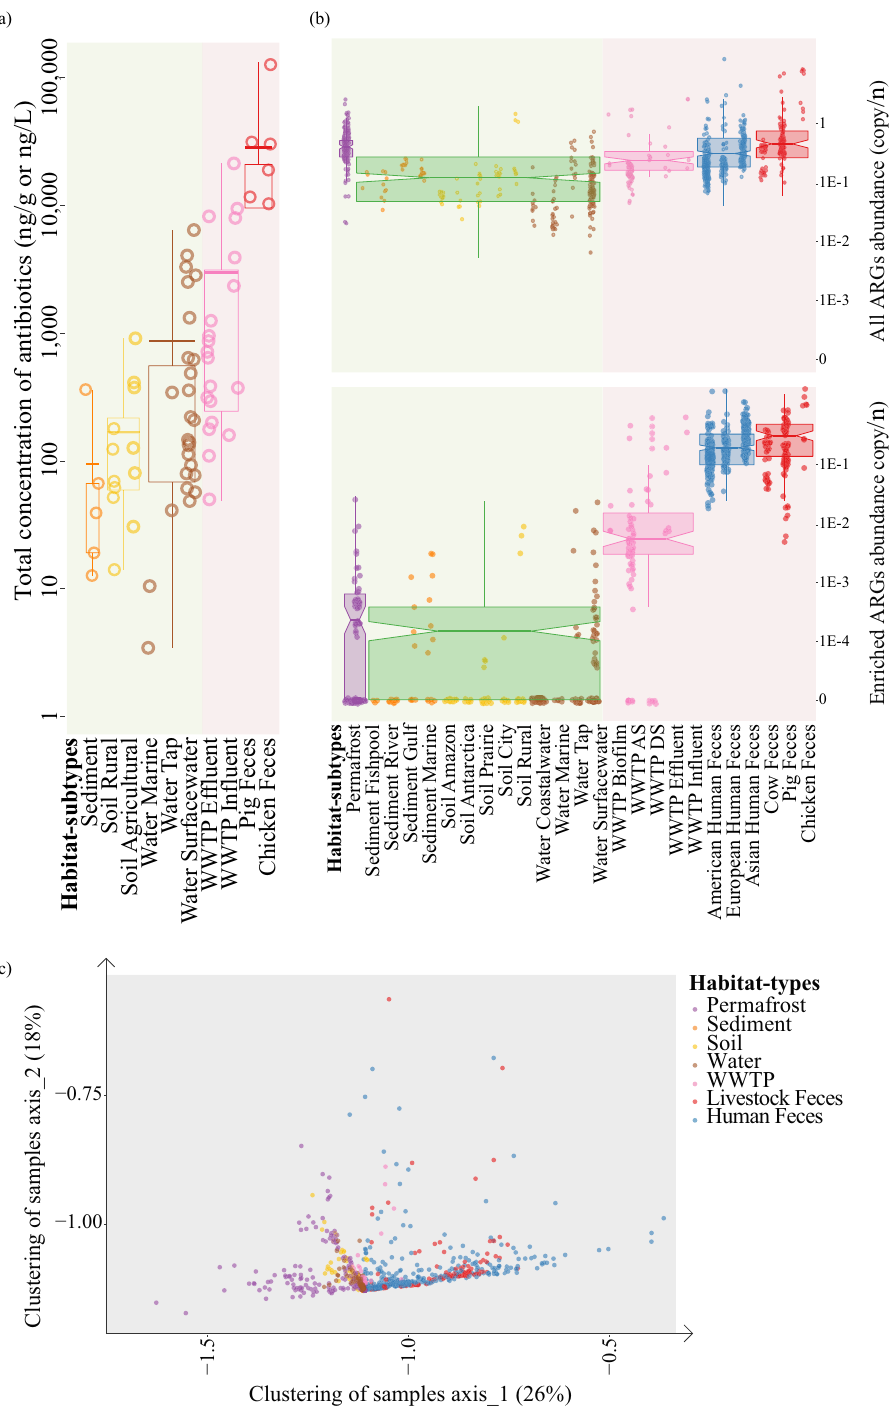
Fig. 1 Survey into the distribution of total antibiotics and antibiotic resistance genes (ARGs) in diverse environments to inform the development of the risk framework. a The total concentrations of total antibiotics ( fi lled circles for ng/L and open circles for ng/g) in different habitats from 30 studies (Supplementary Data 1). Each circle represents a sample, with color representing its habitat. b The abundance of total ARGs and abundance of ARGs in different habitats. Each circle represents a metagenomic sample, with color representing its habitat. The abundance of ARGs was normalized into copy of ARGs per cell (ARGs-OAP, more details in “ Methods ” section). c PCA plotting ARG composition clustered 854 metagenomic samples from seven global eco-habitats into undisturbed natural environments (green panel covering permafrost, soil, sediment, and water) and human associated environments (red panel covering wastewater treatment plants (WWTPs), animal feces and human feces). Samples were clustered into three habitats (from undisturbed natural habitats, to WWTPs, to feces) along the primary axis of “ human-association ” , with its color representing its habitat. Data in a are presented as mean values (center) and 25%, 75% percentiles (bounds of box). Data in b and c are presented as median values (center) and 25%, 75% percentiles (bounds of box). The minima and maxima represent the range of the